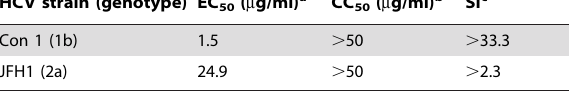
Table 2. Effect of C29EA on HCV replication.